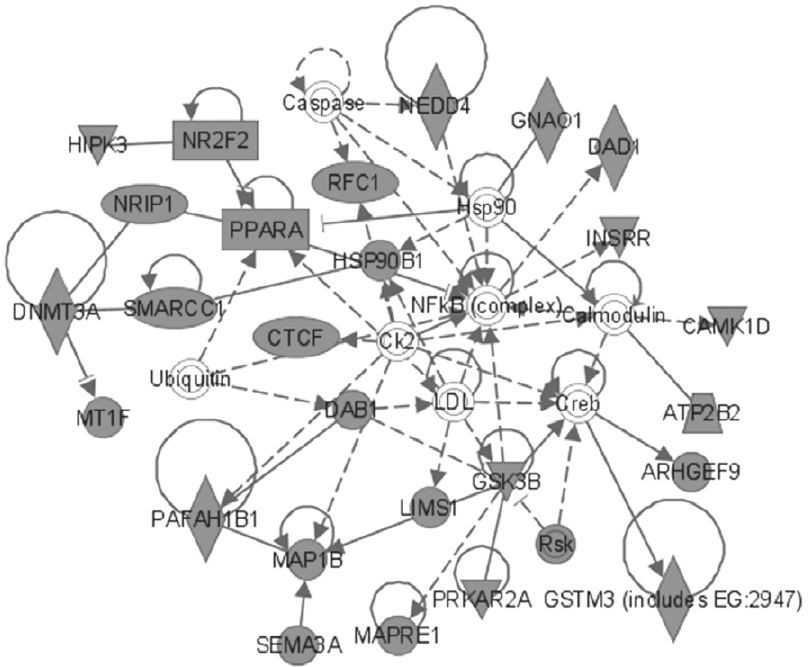
Figure 5. MAM-modulated brain gene products for Mgmt 2 / 2 vs. wild type. Most significant MAM-modulated expression sub-network in the brain of Mgmt 2 / 2 vs. wild type mice (all time-points combined) composed of 153 differentially expressed genes. Note genes involved in epigenetic functions are also modulated: DNMT3A and SMARCC1 regulate chromatin function. doi:10.1371/journal.pone.0020911.g005 PLoS ONE |